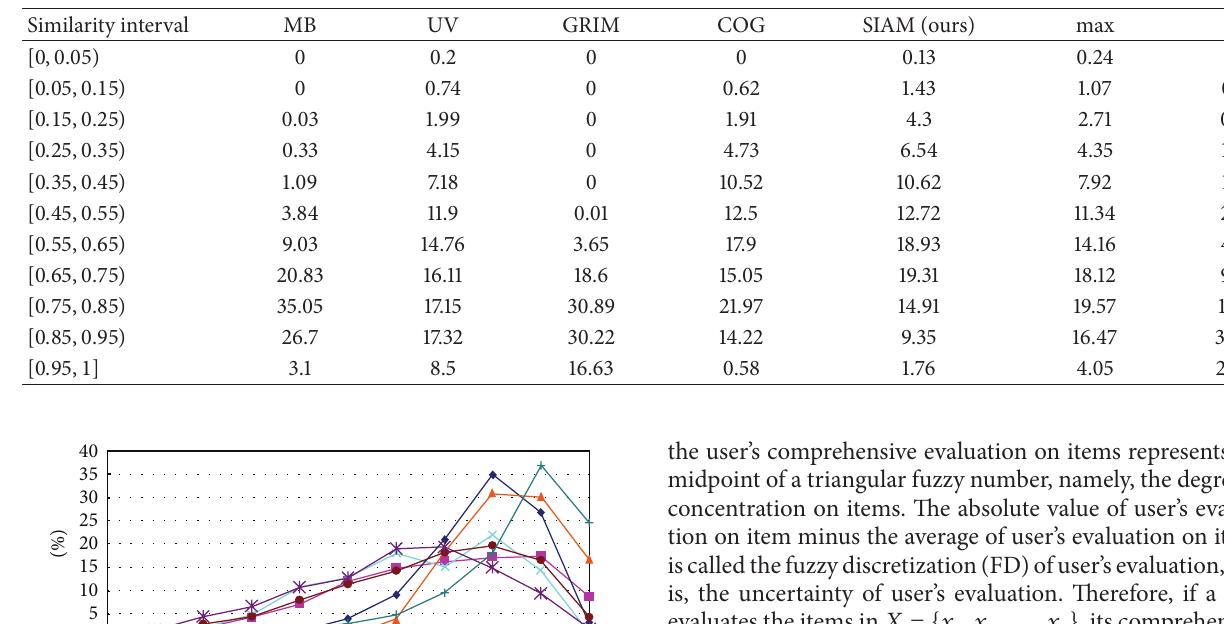
Table 1: Similarity distribution rate of different approaches.